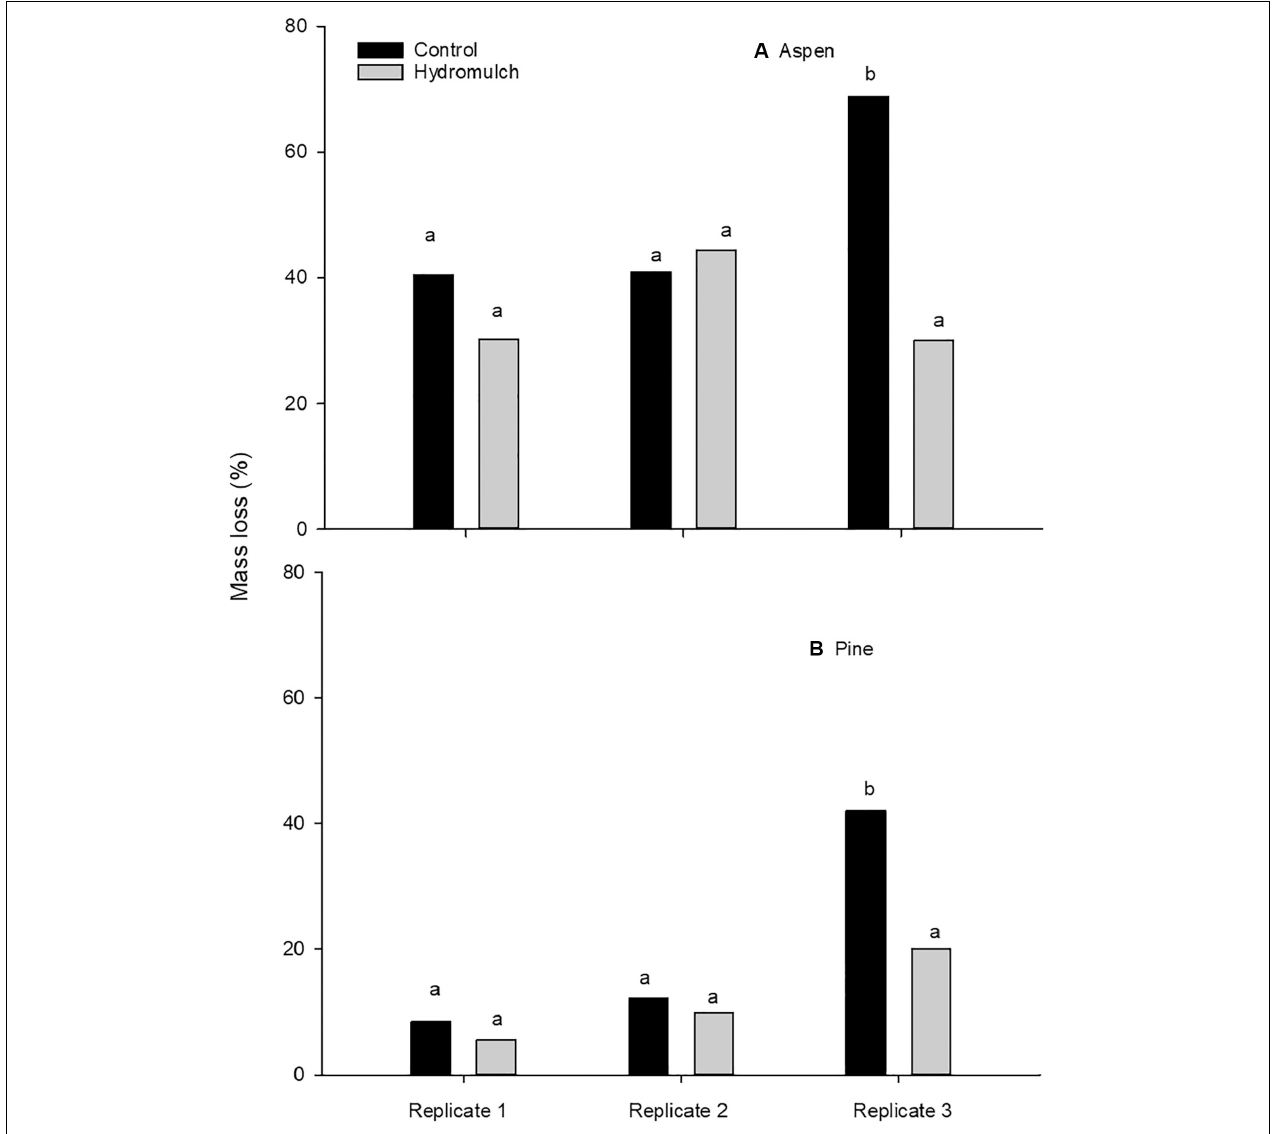
FIGURE 4 | Mass loss of (A) aspen and (B) pine stakes in the mineral soil of three treatment replicates averaged across sampling dates on the Cedar Fire near Alpine, California. Different letters within species indicate a significant treatment difference ( p ≤ 0.05) within replicates.